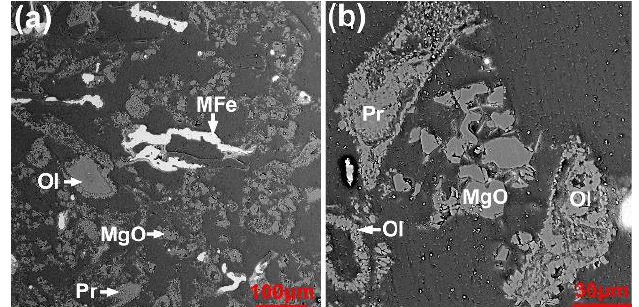
Figure 16. BSE images ( a , × 450; b , × 1750) of the reduced product (after water-leaching) from reduction with the addition of 20 wt% CaCl 2 and 40 wt% MgCl 2 at 1000 ◦ C for 4 h (MFe: metallic Fe; Ol: olivine-type Mg 2 − x Mn x SiO 4 ; Pr: pyrope, Mg 3 Al 2 (SiO 4 ) 3 ).